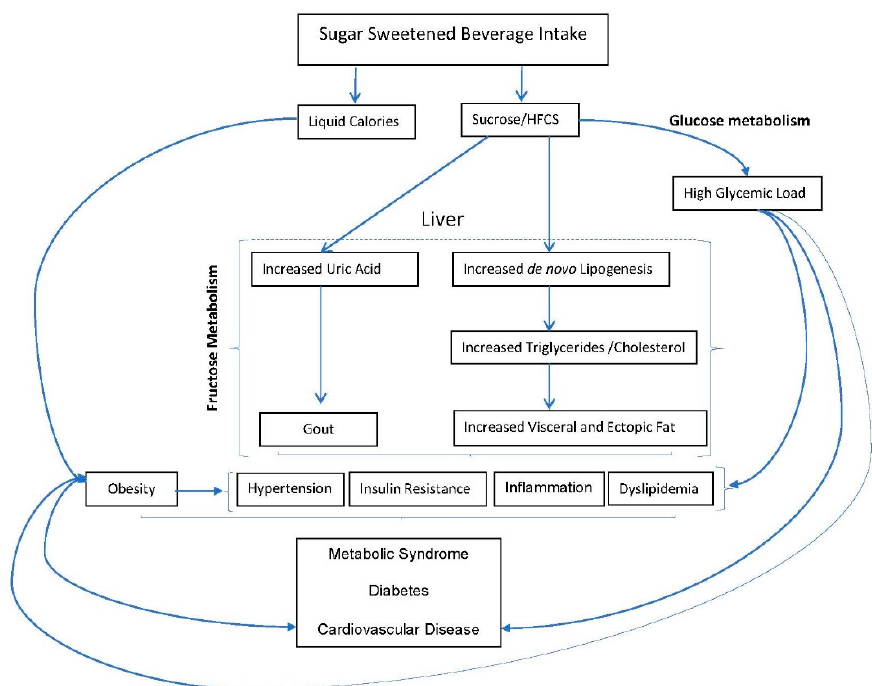
Figure 3. Biological mechanisms linking intake of sugar-sweetened beverages (SSB) to the development of obesity, metabolic syndrome (Met Syn), diabetes, and cardiovascular disease (CVD). Incomplete compensation for liquid calories leads to obesity, which is a risk factor for cardiometabolic outcomes. Increased diabetes, MetSyn, and CVD risk also occur independent of weight through development of risk factors precipitated by adverse glycemic e ff ects and increased fructose metabolism in the liver. Excess fructose ingestion promotes hepatic uric acid production, de novo lipogenesis, and accumulation of visceral and ectopic fat, and also leads to gout. HFCS = high-fructose corn